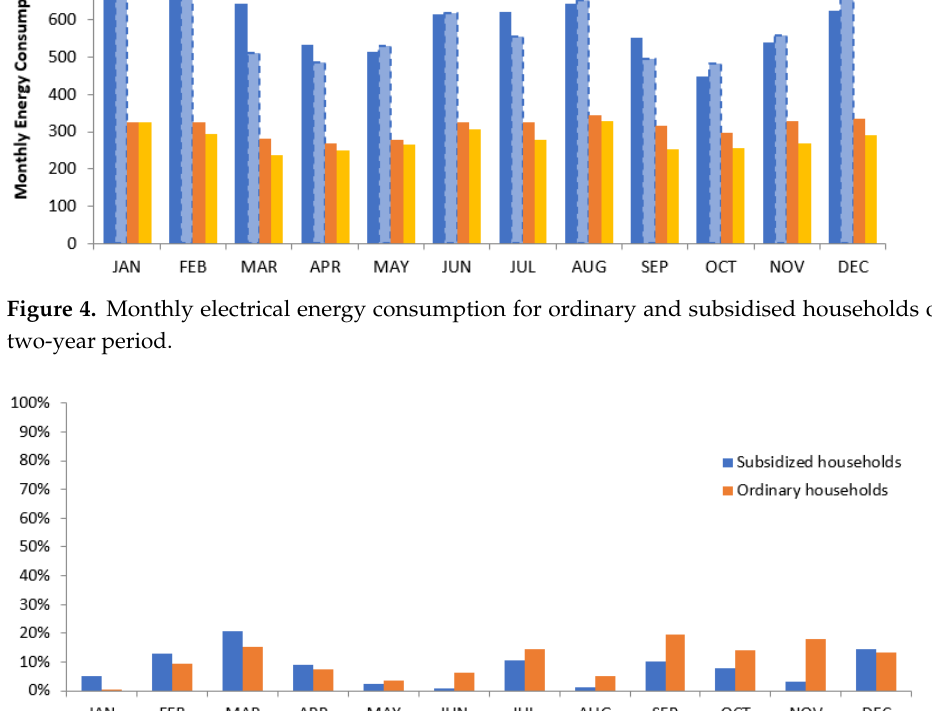
Figure 4. Monthly electrical energy consumption for ordinary and subsidised households over a two ‐ year period.